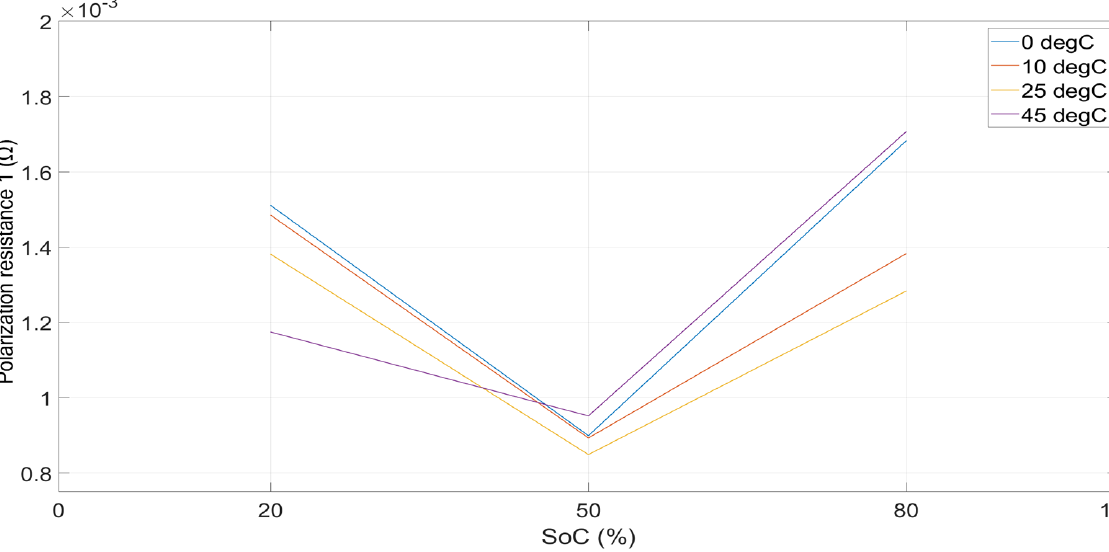
Figure 5. Polarization resistance 1 as a function of temperature and state of charge.